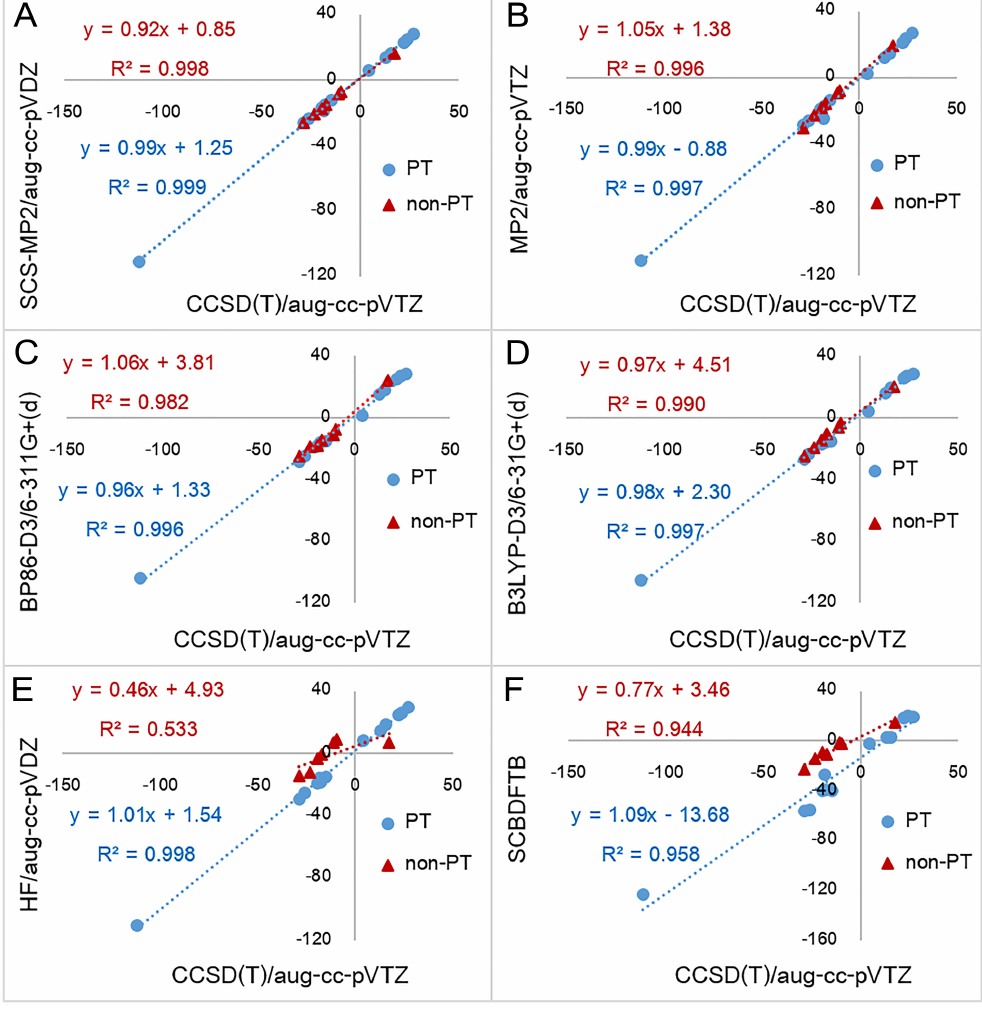
Figure 3 Reaction energies for proton transfer reactions (PT) and non-proton reactions (non-PT) calculated by six quantum chemical methods plotted against with CCSD(T)/aug-cc-pVTZ results. Six quantum chemical methods include (A) SCS-MP2/aug-cc-pVDZ, (B) MP2/aug-cc-pVTZ, (C) BP86- D3/6-311G+(d), (D) B3LYP-D3/6-31G+(d), (E) HF/aug-cc-pVDZ, and (F) SCC-DFTB. All values are in kcal mol − 1 . Full-size DOI: